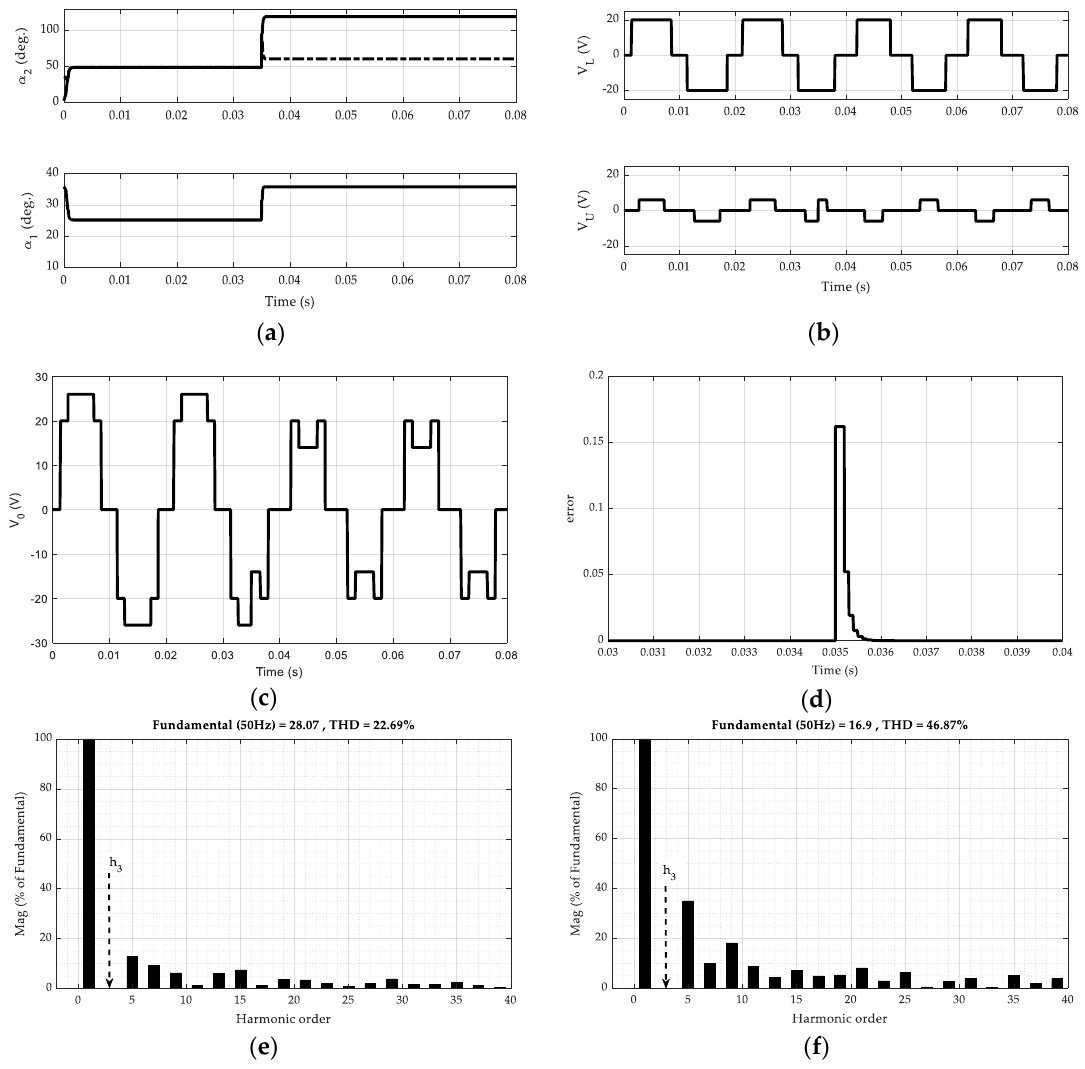
Figure 6. Results of the first case study at V DC1 = 20 V , V DC2 = 6 V , and x = 0.3, in which the third harmonic component is removed and the fundamental component is controlled by applying a step change in MI from 1.08 to 0.65 at 0.035 s: ( a ) α 1 and α 2 , ( b ) V L and V U , ( c ) resulting output voltage, ( d ) controller output signal, and ( e )–( f ) output voltage spectra.